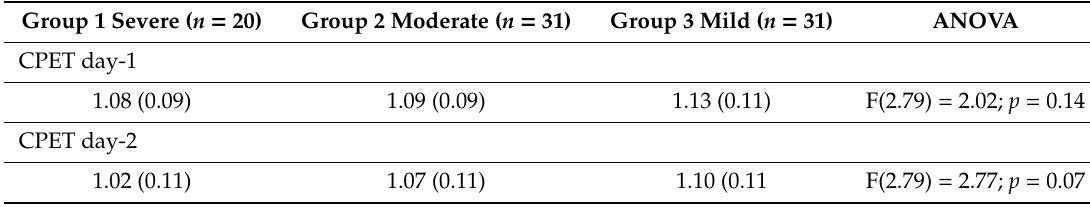
Table 4. RER values for each severity group on each day.